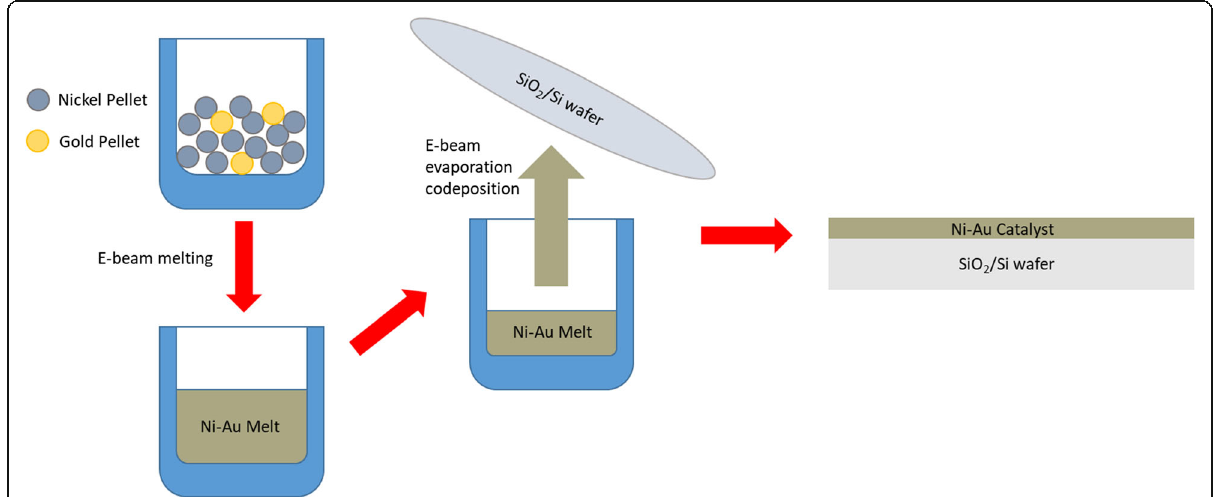
Fig. 1 Schematic diagram of electron beam codeposition technique in which we see the Ni and Au pellets are remotely mixed in a crucible before being evaporated onto the substrate. This process serves to completely remove the necessity for pre-growth annealing used in previous literature and allows for a complete monolayer graphene synthesis at 450